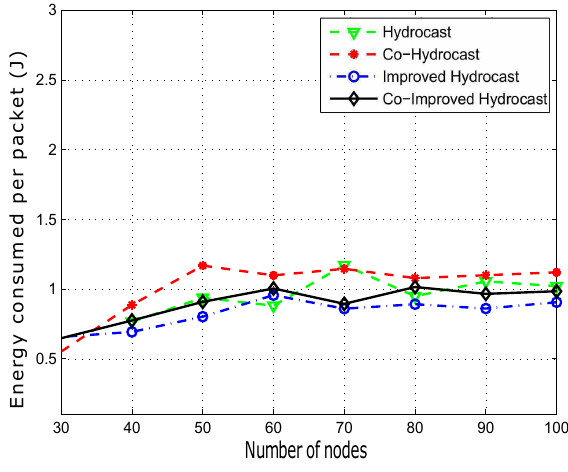
Figure 13. Average end to end energy